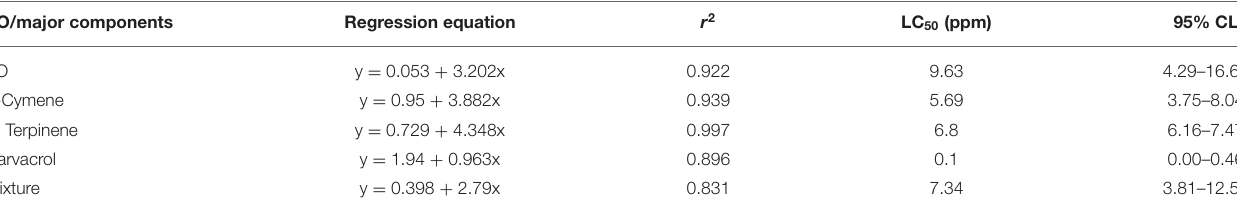
TABLE 3 | Toxicity of Thymus proximus essential oil (EO), p-cymene, γ -terpinene, carvacrol, and their mixture against Aphis gossypii